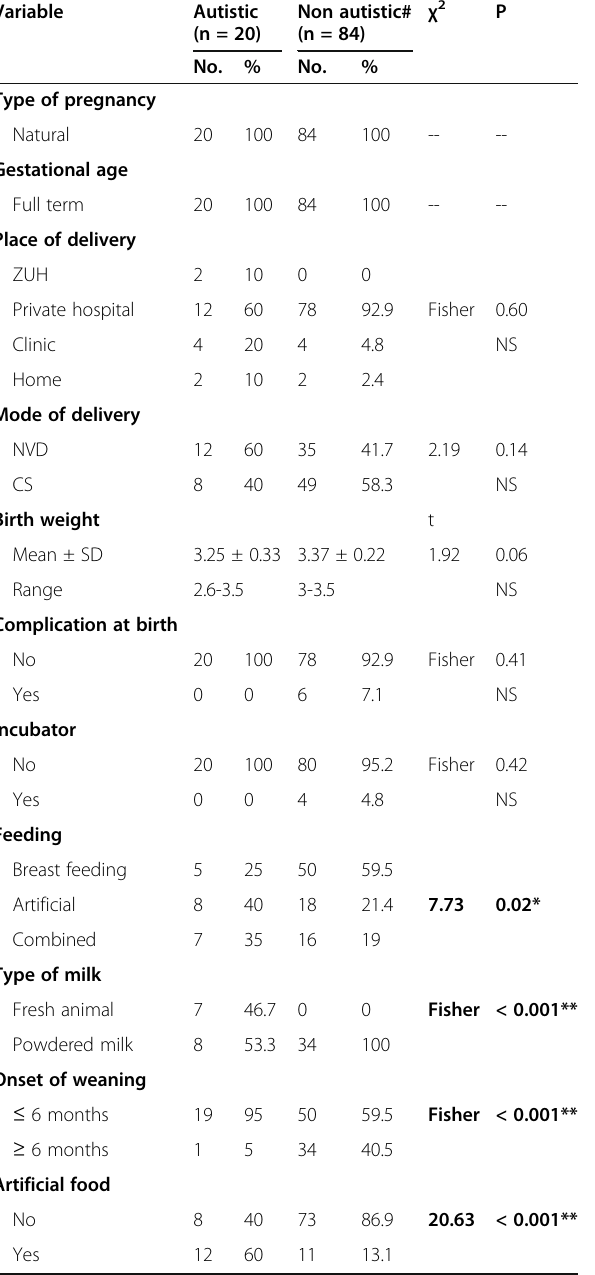
Table 3 Comparison between autistic and non-autistic children in natal and perinatal data